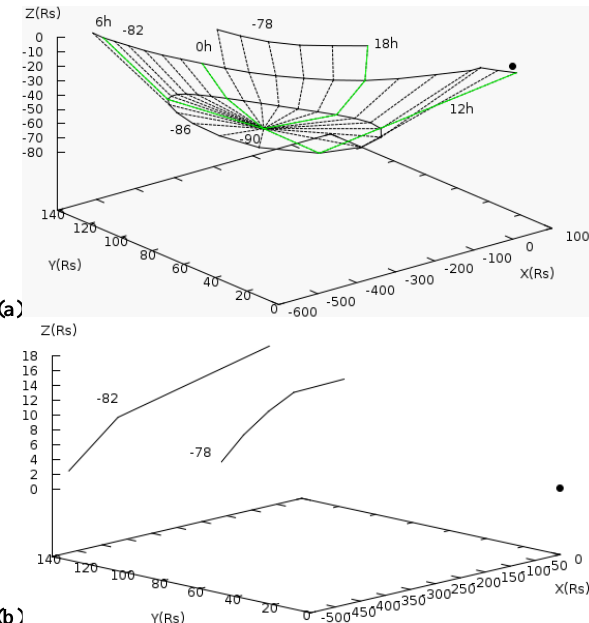
Fig. 8. Intersection points of the open magnetic field lines emerg- ing from Saturn’s southern ionosphere, as shown in Fig. 7, with (a) the southern and (b) the northern magnetopause, for the case of image A with k s = 0 . 2. The format is the same as Fig. 4.